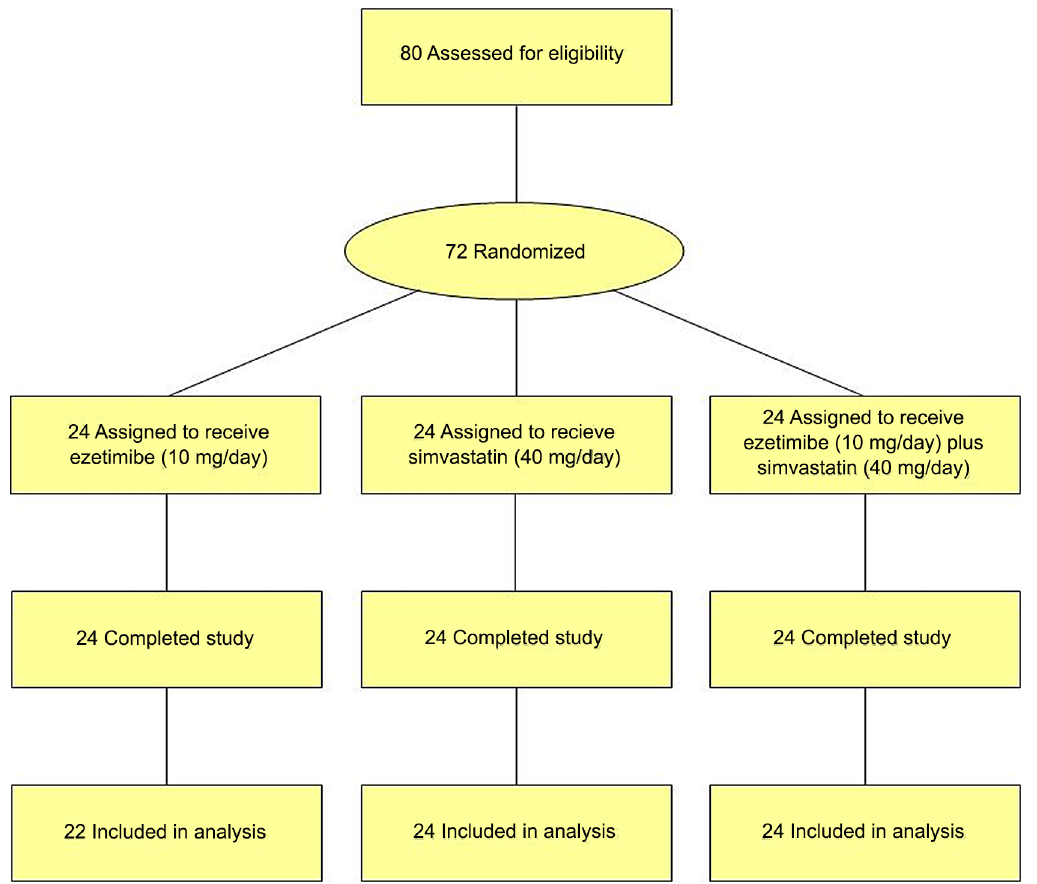
Figure 1. CONSORT flow diagram: Flow of participants through the trial.